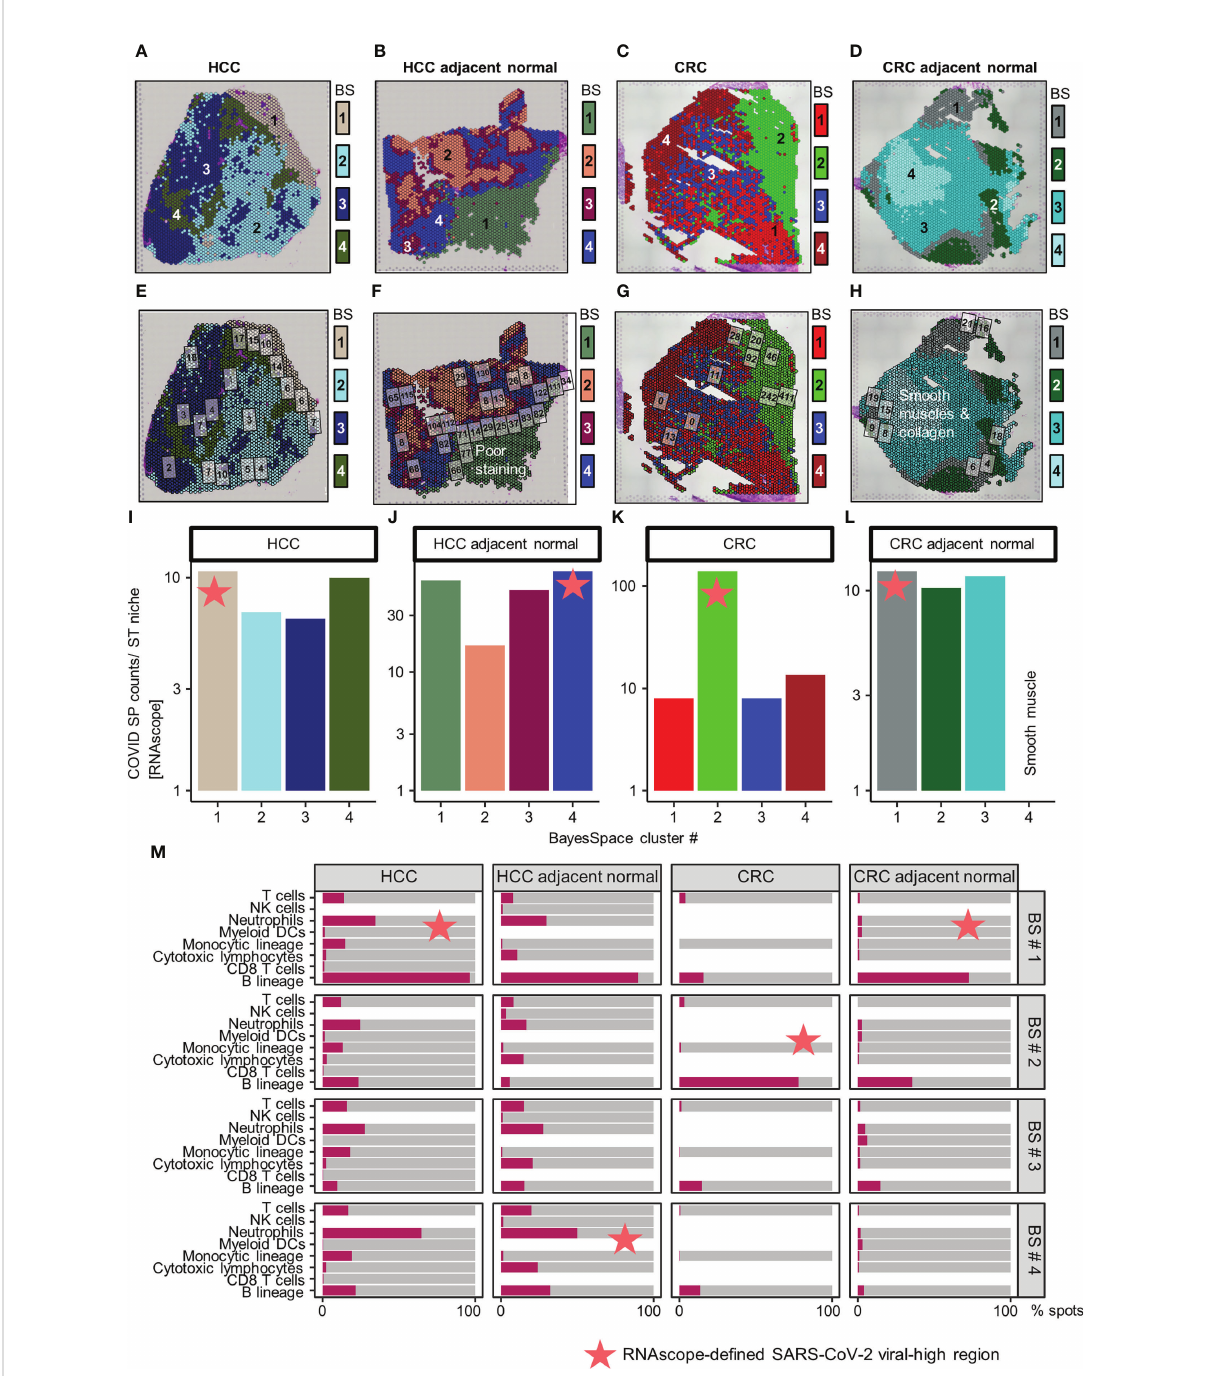
FIGURE 2 Distribution of SARS-CoV-2 spike protein (SP) and immune cell types in the spatial transcriptomic (ST) niches of HCC and CRC biopsies from COVID-19-recovered patients. (A – D) From left to right: HCC, HCC-adjacent normal, CRC, and CRC-adjacent normal tissues; ST niches (clusters 1 – 4) were determined using the spatially-aware BayesSpace (BS) transcriptomic clustering method. (E – L) RNAscope-detected SARS-CoV-2 SP was quanti fi ed in regions of interest (marked as boxes) in the Visium-de fi ned ST niches (E – H) ; see Supplementary Table 2 for raw data and assignment of ROIs to ST niches. Bar charts (I – L) show the relative SP counts in the ST niches; SP counts in ROIs assigned to the same ST niche were averaged. Areas with poor staining quality (F) and smooth muscle and collagen (H, L) were omitted. (M) Distribution of immune cell abundance (estimated by a deconvolution-based microenvironment cell population-counter) in ST niches. The orange stars indicate viral-high regions (ST niches with the highest SARS-CoV-2 SP